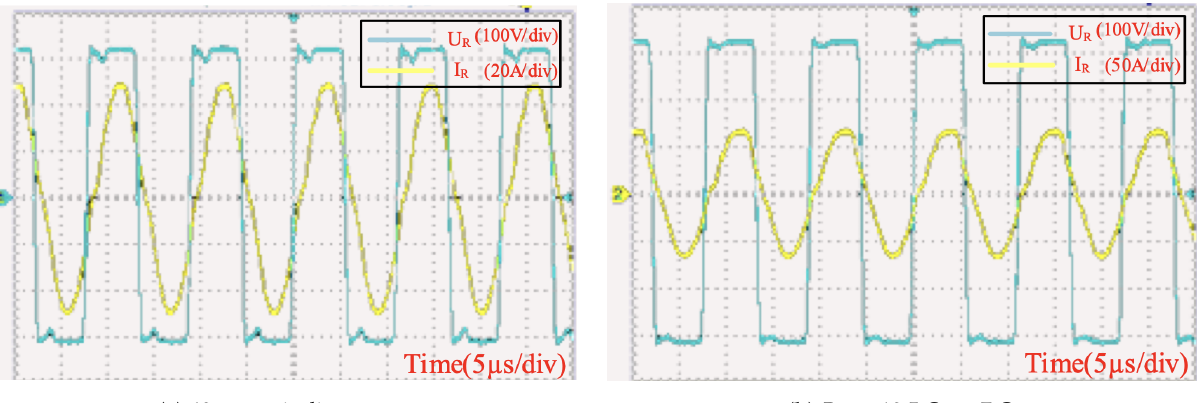
Figure 19. Receiver-side current and